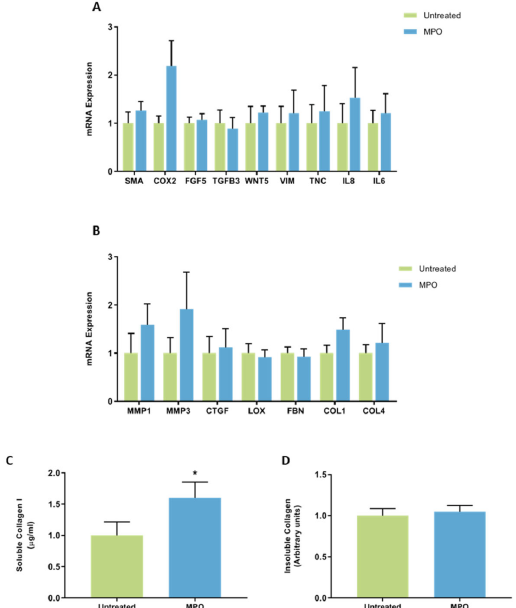
Figure 4. The effect of MPO on mRNA expression and collagen production in mammary fibroblasts. Messenger RNA expression of cancer-associated genes ( A ) and genes involved in extracellular matrix regulation and collagen production ( B ) measured by RT-PCR in human mammary fibroblasts following treatment with 5 µ g/mL of MPO for 72 h. mRNA expression normalised to HPRT1 expression and presented as relative expression where the average for the untreated control is 1. Collagen production was measured using collagen 1 ELISA ( C ) and insoluble collagen measured by sirius red staining ( D ). Data presented as mean + SEM with statistical analysis performed using a linear mixed-effects model Tukey’s post hoc comparison. Statistical significance indicated by * when p <